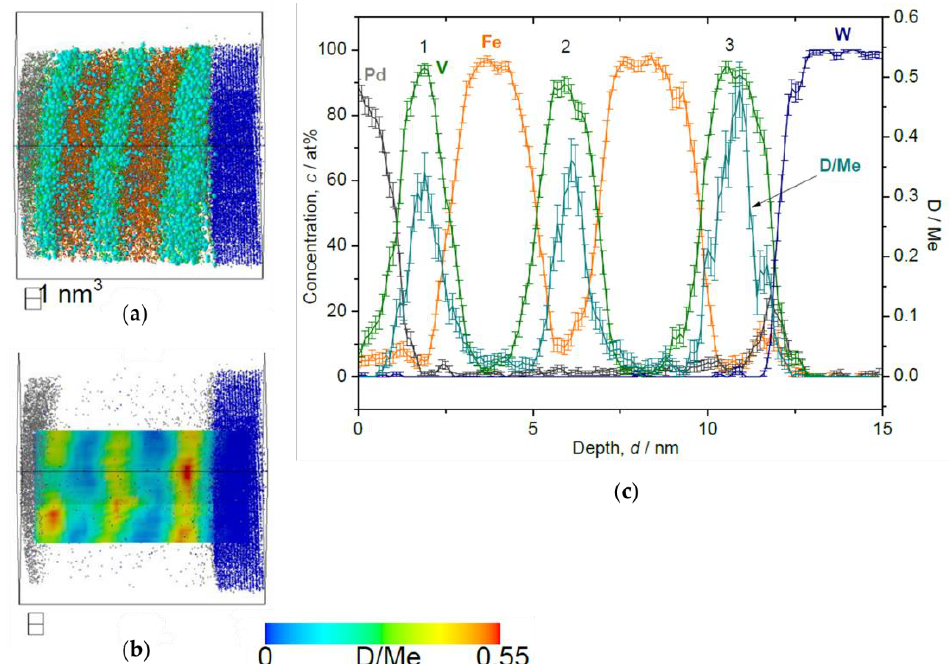
Figure 12. Reconstructed volume of Fe/V multi-layer (12 nm × 12 nm × 16 nm), loaded with D 2 1000 Pa, analyzed at 30 K. ( a ) The whole volume of reconstruction (grey: Pd, green: V, orange: Fe, blue: W, light blue: D). ( b ) Iso-concentration map of D concentration ( c D = 0.55 D/Me) from the same reconstruction in ( a ). ( c ) Depth concentration profile from 5 nm ϕ cylinder volume.